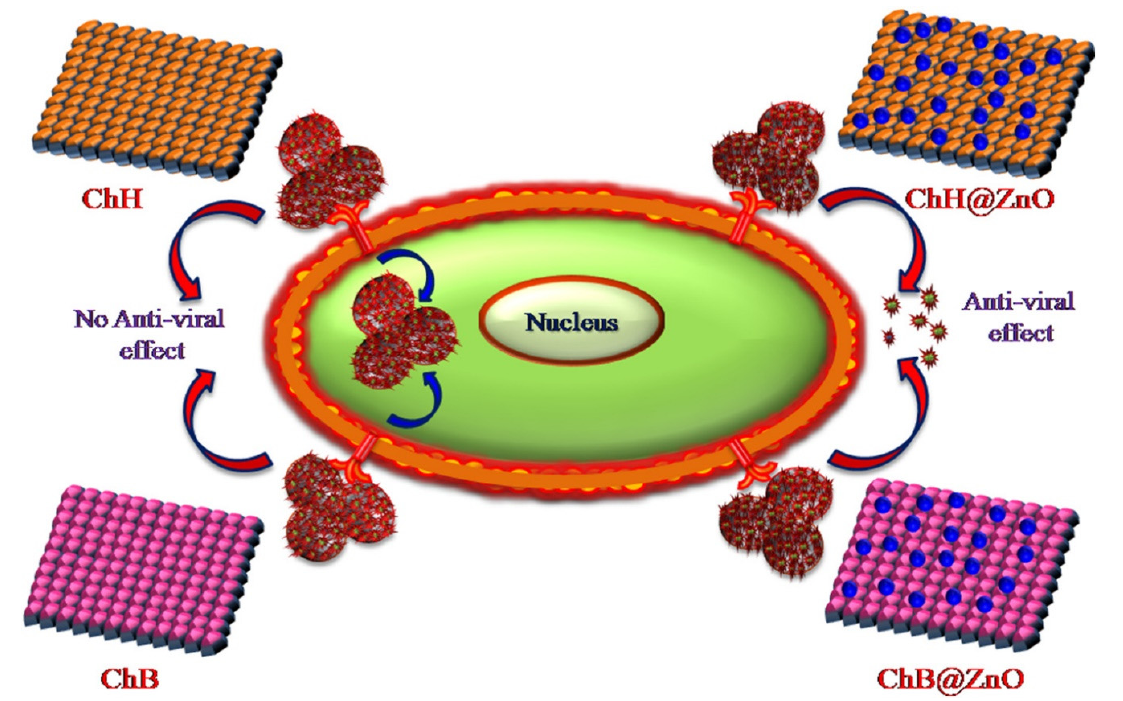
Figure 16. Probable mechanism of antiviral activity by the nanocomposites [245]. Reproduced with permission from Elsevier (Copyright©2022).